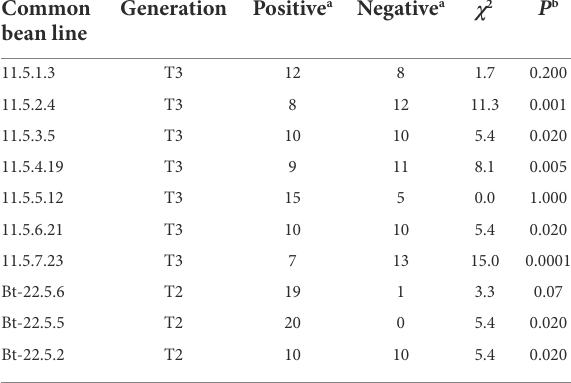
TABLE 1 Progeny analysis of T 2 and T 3 generations of transgenic common bean cv. Olathe Pinto lines ( n = 20). Common bean